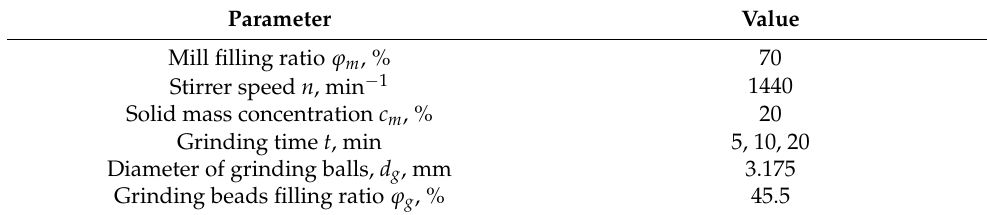
Table 3. The main grinding parameters in the laboratory stirred ball